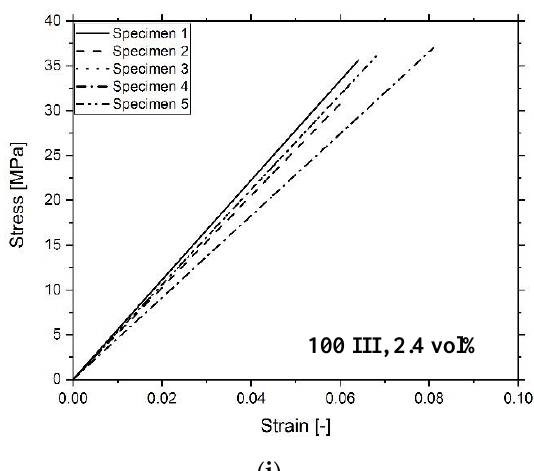
Figure A4. Stress-strain curves of unmodified ( a ), 13 nm ceramic modified ( b – d ), 35 nm ceramic modified ( e – g ), 100 nm ceramic modified ( h – j ) photopolymers. The filler content for each of the three particle sizes is shown in the diagrams. Table A1. The viscosity of the samples after filtration at 60 °C and a shear rate of 500 s −1 . The surface tension of the inks after filtration.